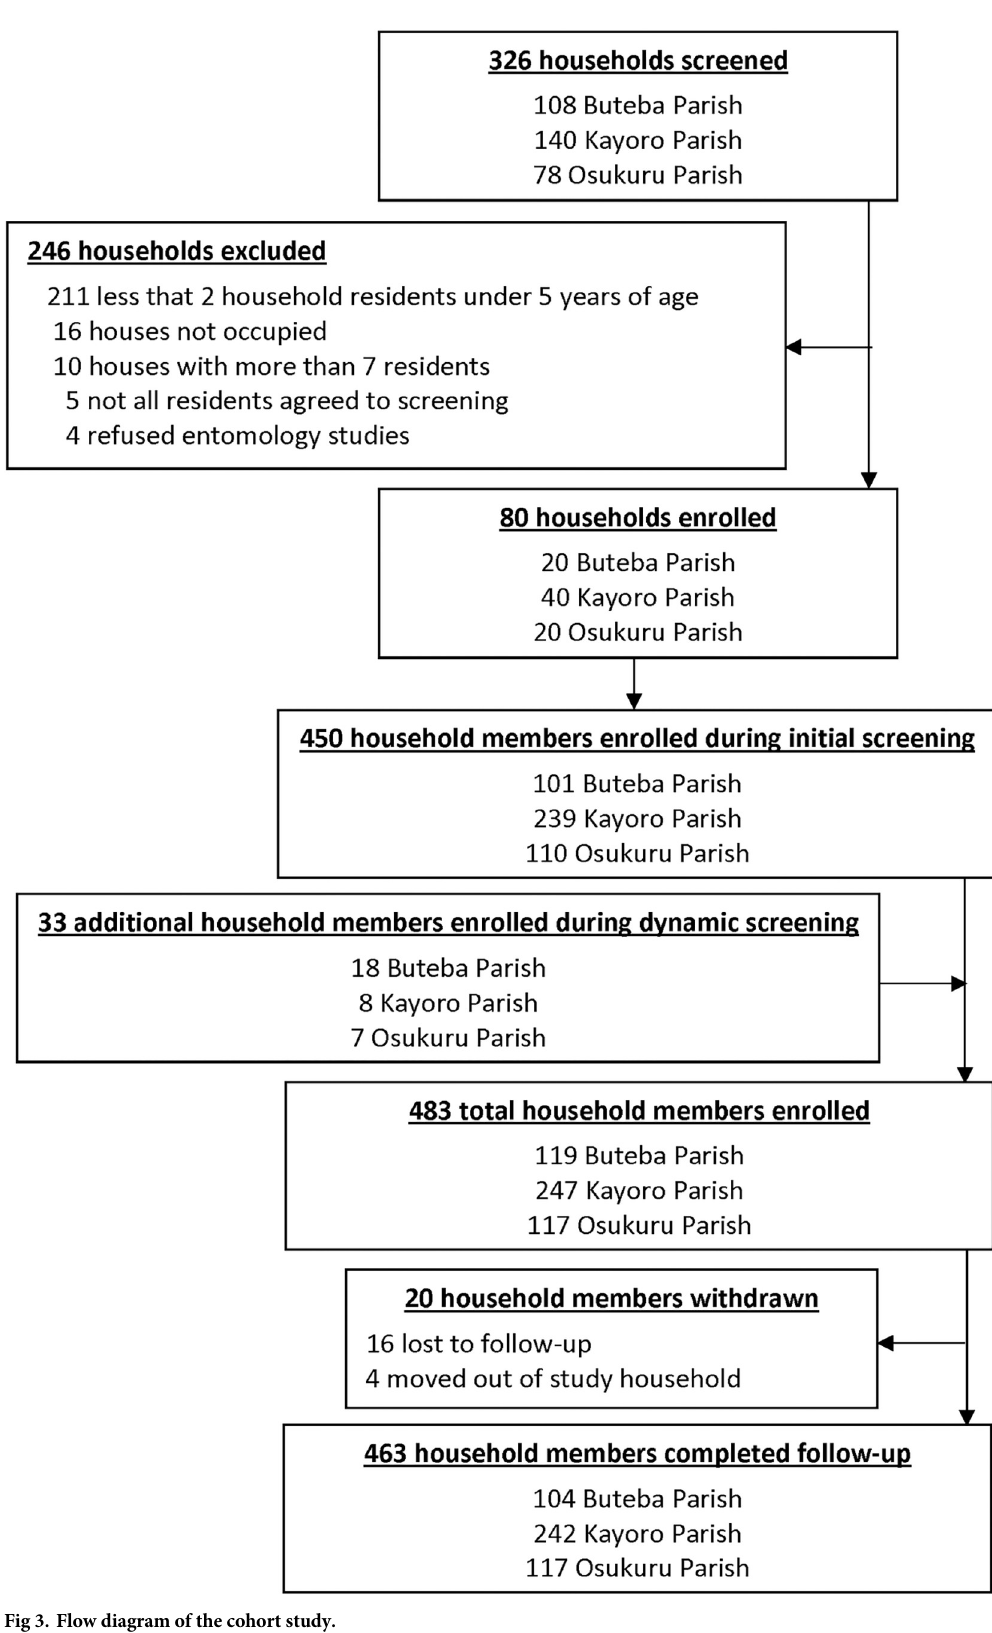
Fig 3. Flow diagram of the cohort